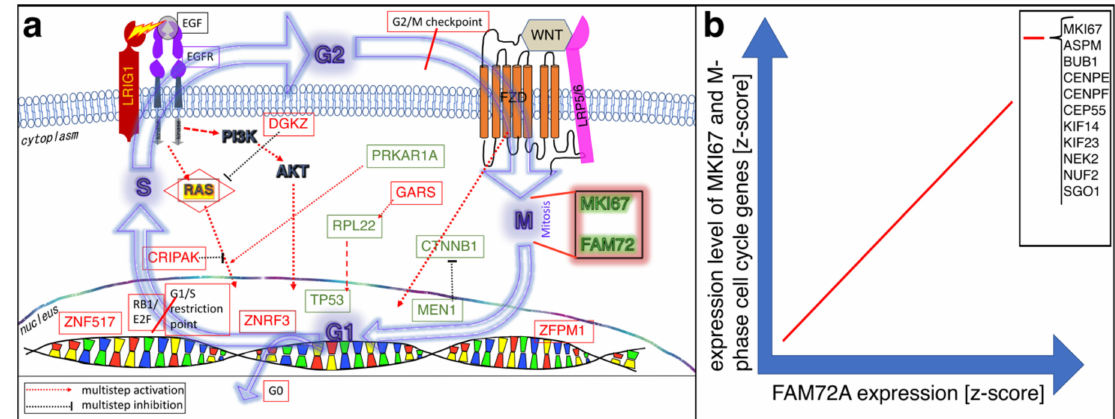
Figure 3. Experimental evidence-based schematic illustration of FAM72 and MKI67 co-activation in adrenocortical carcinoma (ACC). ( a ) Mutations in ACC-specific driver proto-onco- or tumor-suppressor-genes (red and green color) push the cell through the cell cycle and mediate MKI67 as well as FAM72 expression during the M-phase. Red-colored proto-oncogenes (or tumor-suppressor genes) are from Rahane et al. [28], while green-colored proto-oncogenes (or tumor-suppressor genes) are from Zheng et al. [29]; additional ACC-specific cell cycle information are from Assi é et al. [30], Lippert et al. [31], and Pereira et al. [32]. Tumor suppressor LRIG1 interferes with EGFR signaling and might be a druggable protein of primary interest [33–35]. ( b ) Schematic illustration of mRNA expression correlation between FAM72A on the one hand and M-phase cell cycle genes, including MKI67, on the other hand. FAM72A expression correlates with the expression of cell cycle phase-specific genes across various human cancer tissue. Genes specifically associated with the late G2- to M-phase of the cell cycle, including ASPM, BUB1, CENPE, CENPF, CEP55, KIF14, KIF23, NEK2, NUF2, and SGO1 (ASPM, BUB1, CEP55, KIF14, KIF23, and NEK2 are involved either with spindle formation or with regulation; CENPE, CENPF, NUF2, and SGO1 are involved in the centromere-kinetochore complex) [12,28]. ASPM, Assembly factor for spindle microtubules; BUB1, Budding uninhibited by benzimidazoles 1 mitotic checkpoint serine/threonine kinase; CENPE, Centromere protein E; CENPF, Centromere protein F; CEP55, Centrosomal protein 55; CRIPAK, Cysteine-rich p21-activated protein kinase 1 inhibitor; CTNNB1, Catenin beta 1; DGKZ, Diacylglycerol kinase zeta; FZD, Frizzleds; GARS1, Glycyl-tRNA synthetase 1; KIF14/23, Kinesin family member 14/23; LRIG1, Leucine rich repeats and immunoglobulin-like domains 1; NEK2, Never in mitosis gene a-related kinase 2; NUF2, NUF2 component of NDC80 kinetochore complex; RPL22, Ribosomal protein L22; PRKAR1A, Protein kinase cAMP-dependent type I regulatory subunit alpha; RAS, Rat sarcoma; SGO1, Shugoshin 1; WNT1, Wingless and Int-1 family member 1; ZFPM1, Zinc finger protein, friend of GATA family member 1; ZNF517, Zinc finger protein 517; ZNRF3, Zinc and ring finger